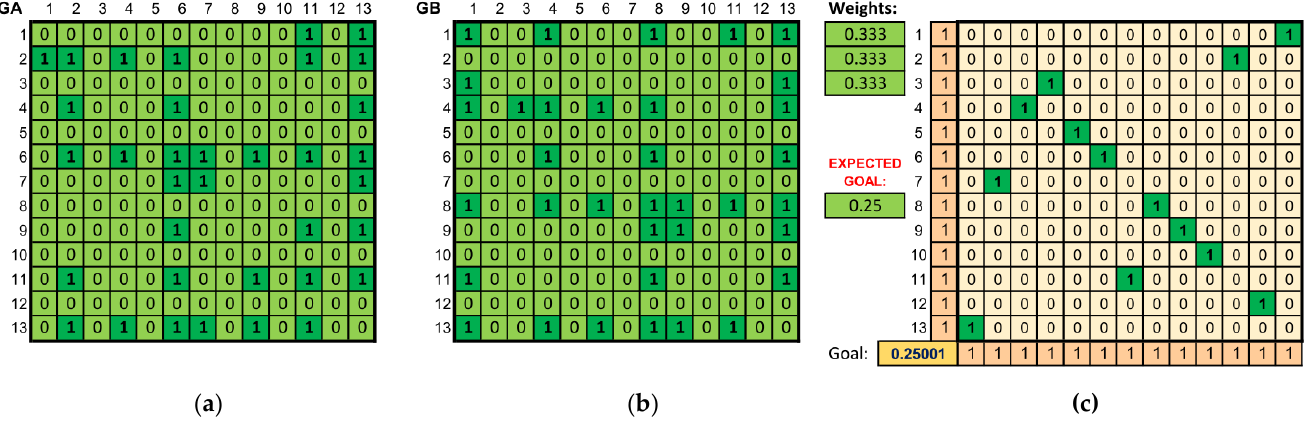
to another (maximizing graph similarity) together with the value of the objective function.